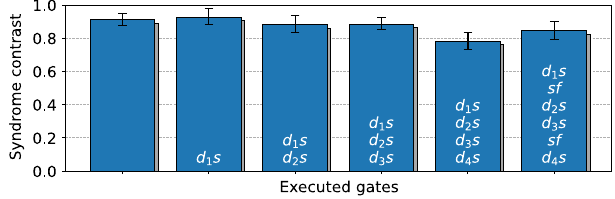
FIG. 7. Readout syndrome contrast after last gate with increas- ing number of gates executed, based on 160 shots per Pauli operator X , Y .